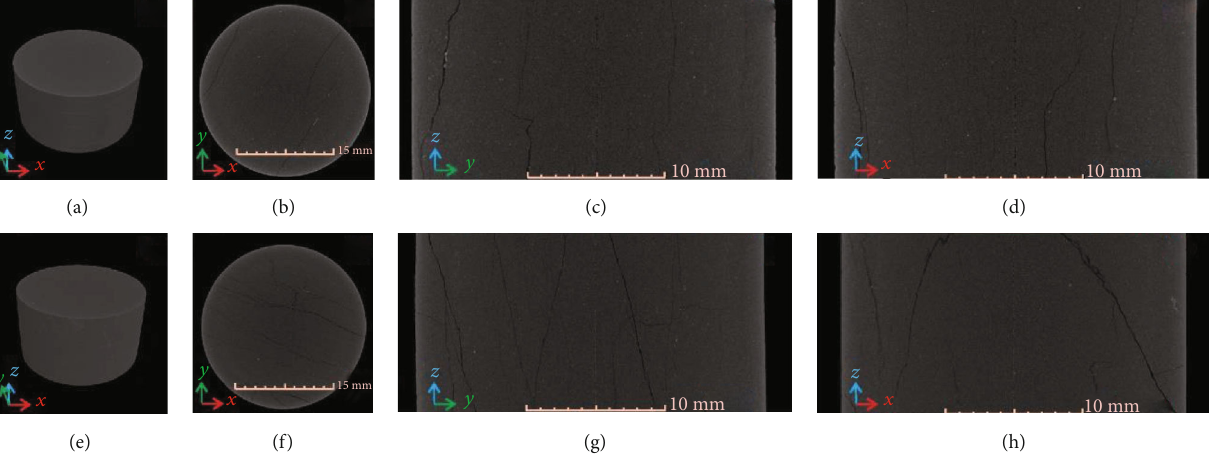
Figure 8: 3D CT images of sample 7 before being pressed and after being pressed. (a – d) 3D CT images of sample 7 before being pressed. (e – h) 3D CT images of sample 7 after being pressed.